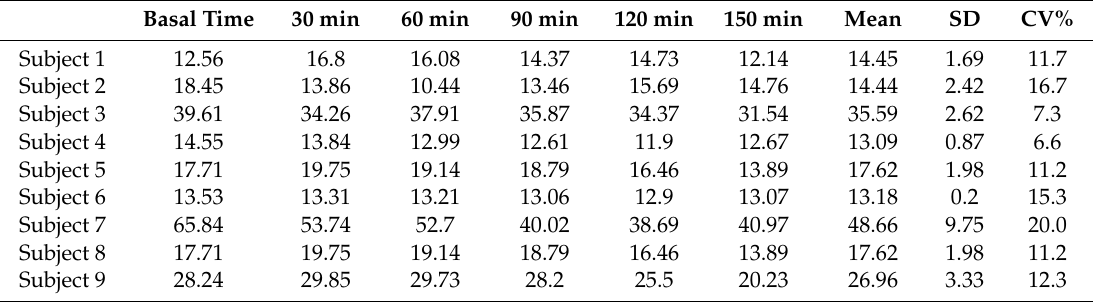
Table 2. Intra-assay coefficient variability (intra-assay CV) of PAOT-Skin Score ® calculated (12.46 ± 4.29%) from a population of nine healthy volunteers (Group IIb). Basal